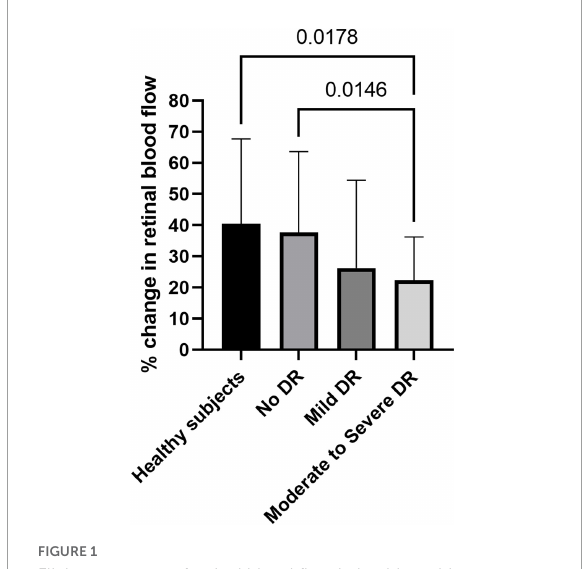
FIGURE1 Flicker response of retinal blood flow in healthy subjects, patients with no diabetic retinopathy (no DR), mild diabetic retinopathy (mild DR), and moderate to severe diabetic retinopathy (moderate to severe DR). Data are presented as mean ± SD. Planned comparisons were used to calculate p -values between groups.